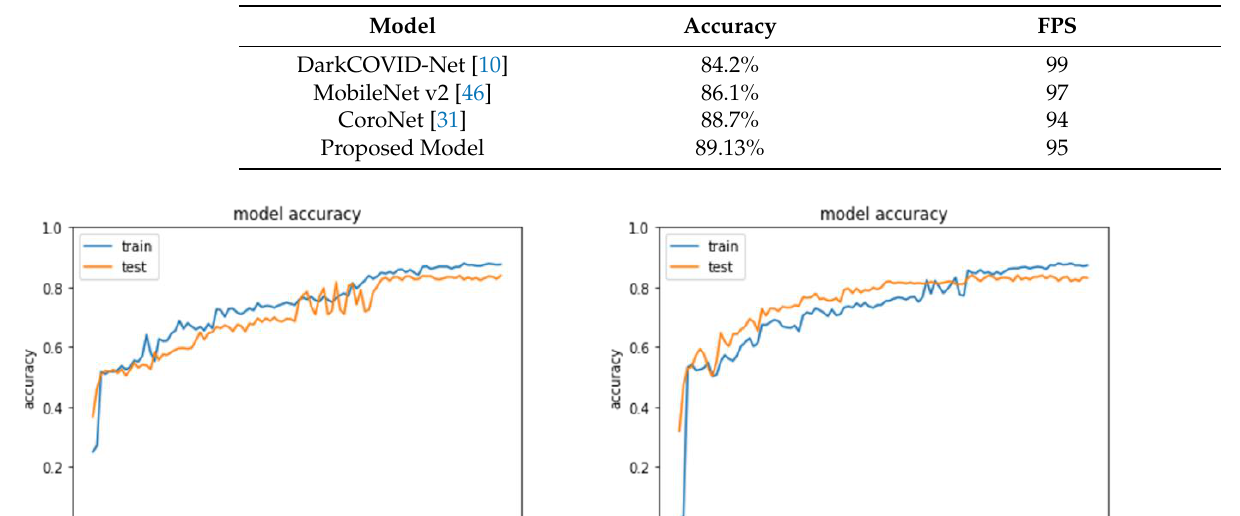
Table 3. Accuracy and speed comparison with state-of-the-art classifiers.